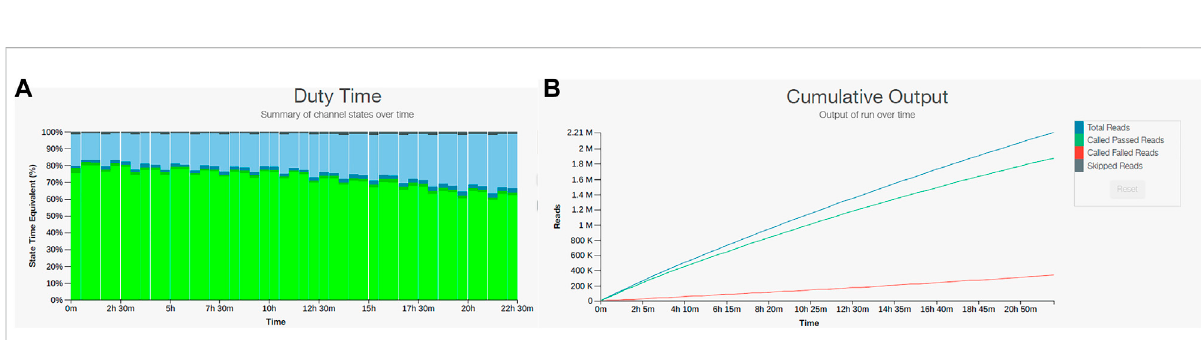
FIGURE 4 Nanopore sequencing output for sample 9 using the LSK109 ligation kit. (A) Pore sequencing and availability remained above 60% for the 24- hour sequencing run. (B) Cumulative output of the LSK109 kit showed more than 85% of total reads passed the quality fi